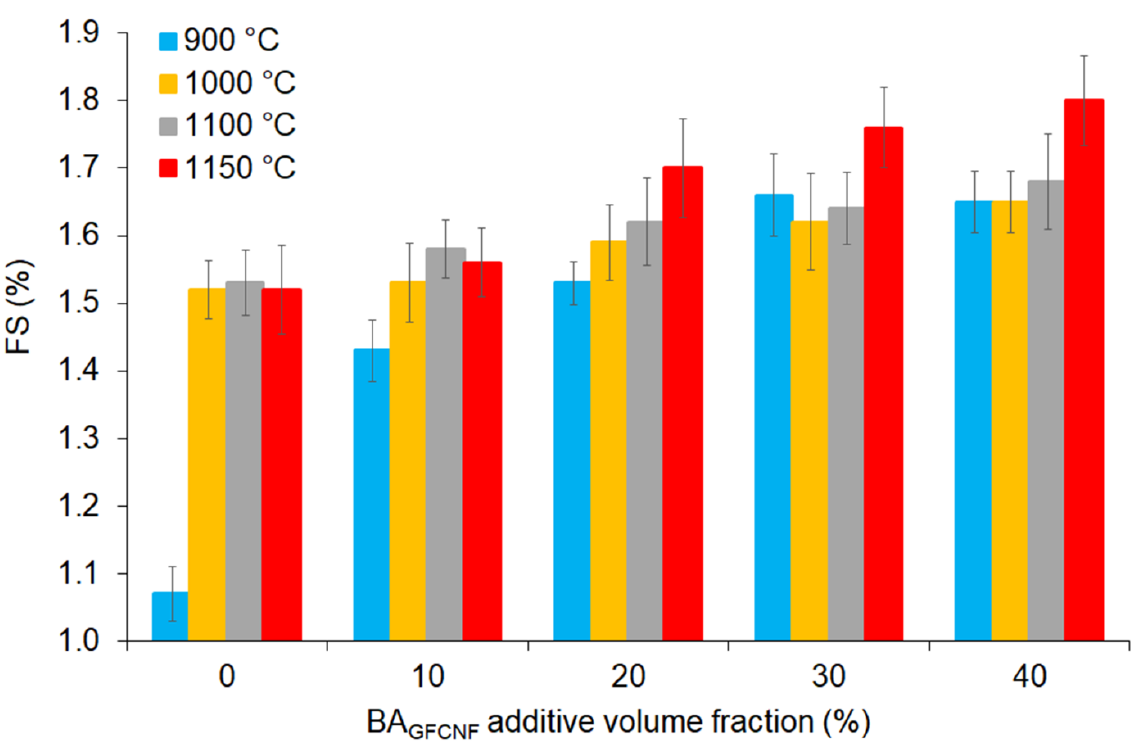
Figure 3. The values of FS depending on the BA GFCNF content, which ranged from 0 to 40%, and firing temperatures applied in the range of 900 to 1150 °C .